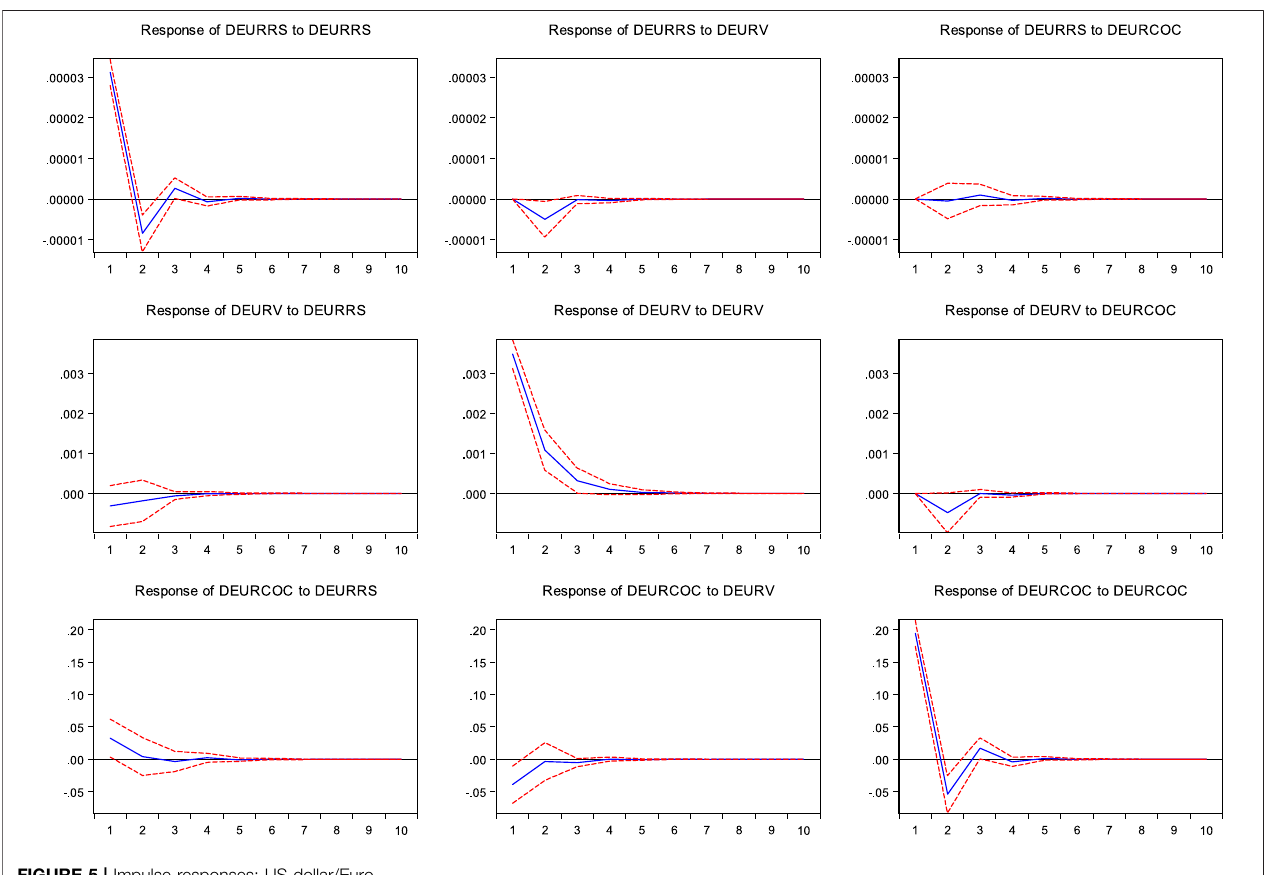
FIGURE 5 | Impulse responses: US